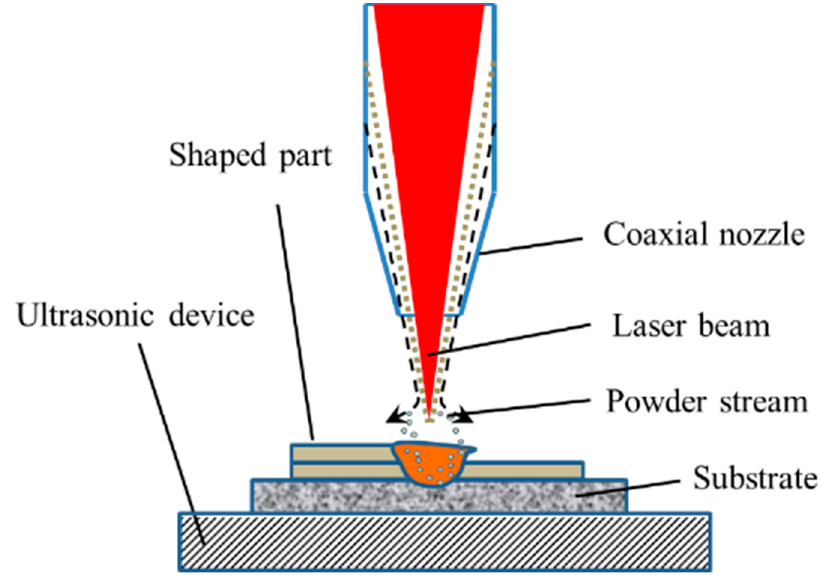
Figure 1. Working principle of the equipment.